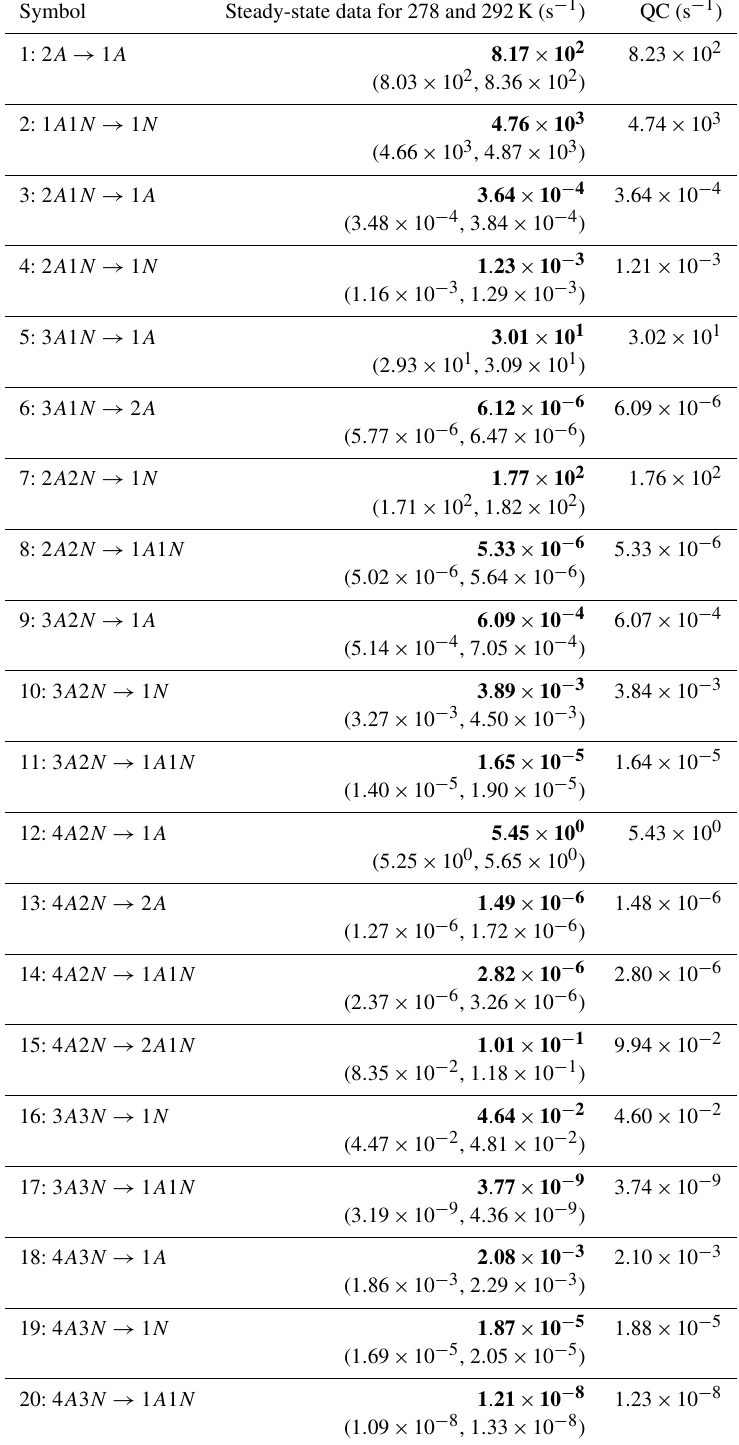
Table D2. Evaporation rates at temperature 278K (units given in s − 1 ) computed from a posterior distribution of the thermodynamic param- eters (cluster formation enthalpies and entropies) which had previously been determined from the steady-state concentration measurements at temperatures 278 and 292K. Here, the mode of distribution (in bold) is given together with the range of possible values in the parentheses. The last column presents the quantum-chemistry-based evaporation rates used for creating the synthetic data (borrowed from Olenius et al., 2013b). The notation xAyN corresponds to a cluster with x sulfuric acid and y ammonia